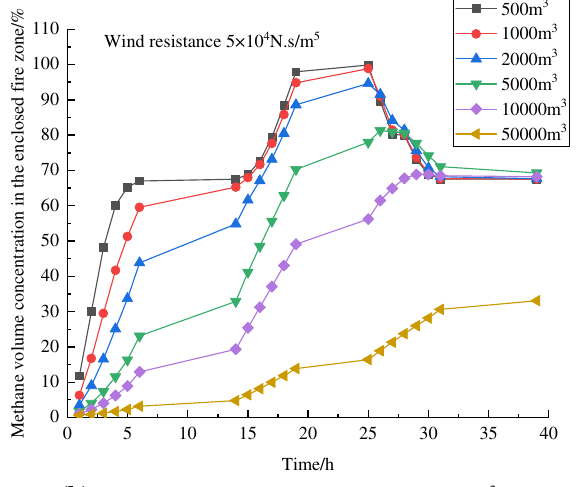
(b) Absolute gas emission in the fire zone 1m 3 /min Fig. 13 Different gas emission, different fire zone volume, and large wind resistance, the changes of gas concentration in the fire zone with time after the completion of closing at 24:00 midnight